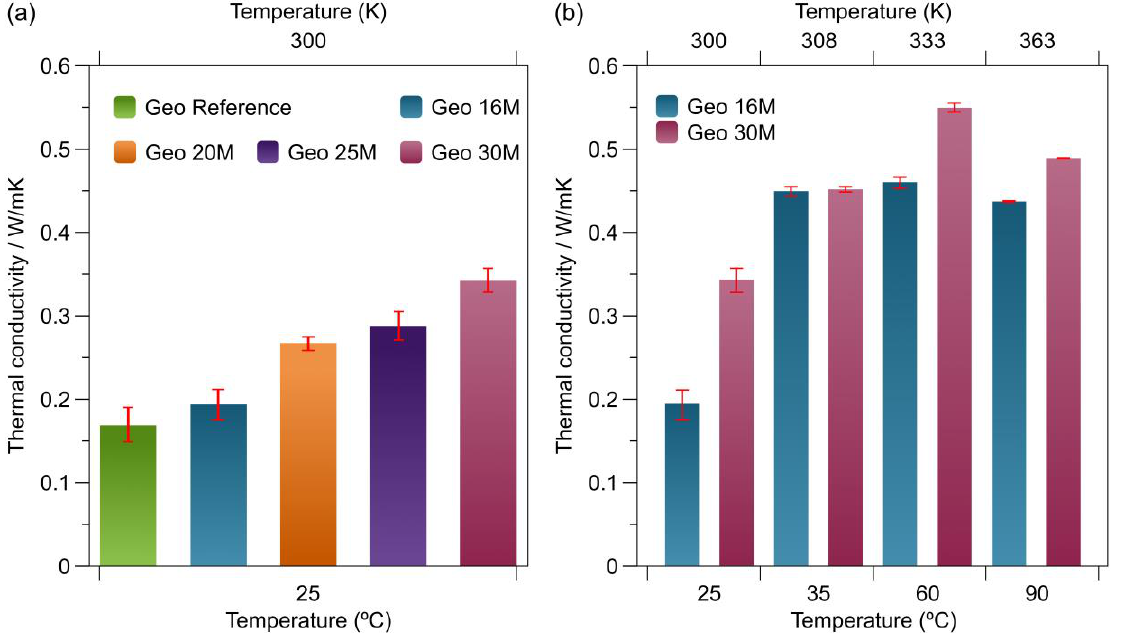
Figure 6. Bar plots of thermal conductivity: ( a ) Geo 16M, Geo 20 M, Geo 25M, and Geo 30M at 25 ◦ C; ( b ) Geo 16M and Geo 30M at temperatures ranging from 25 to 90 ◦